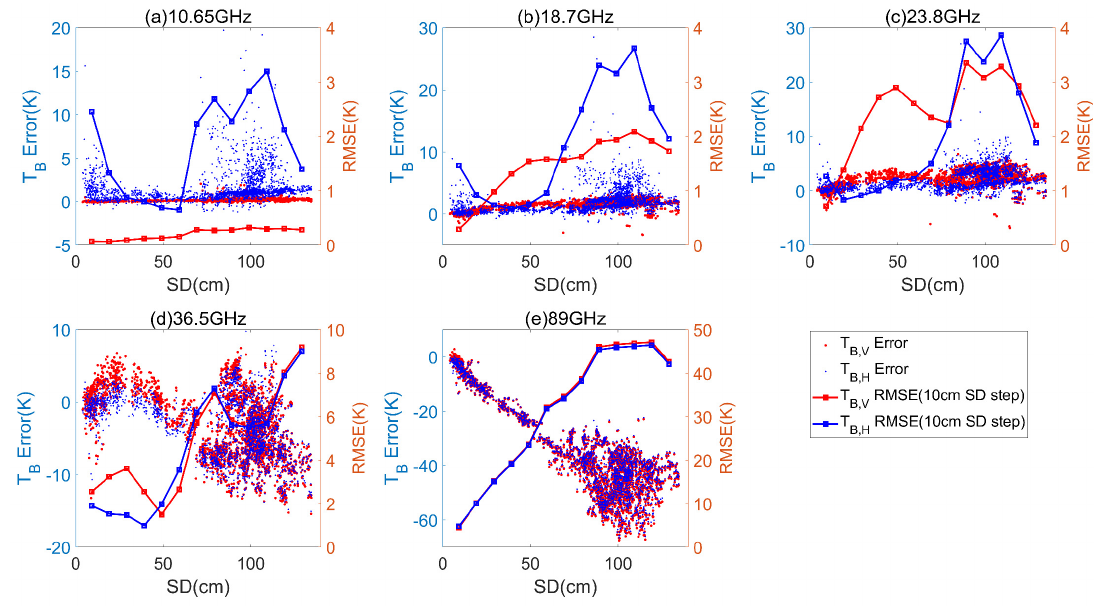
Figure 13. Sensitivity of brightness temperature (T B ) Error to snow depth (SD) at a 55 ◦ incidence angle: ( a ) 10.65 GHz; ( b ) 18.7 GHz; ( c ) 23.8 GHz; ( d ) 36.5 GHz; and ( e ) 89 GHz. The scatter points are T B Error of different samples. The lines are the T B RMSE summarized at 10 cm SD step. It was calculated using samples ± cm around each SD step. The results at the vertical polarization are presented in red and horizontal polarization are presented in